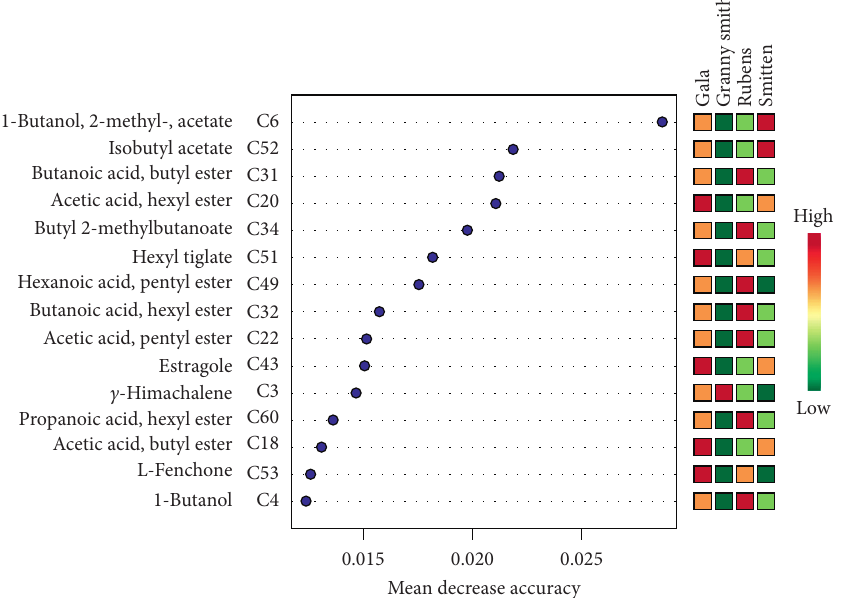
Figure 2: Representations of variety specific volatile signatures. Significant features identified by random forest within the full data set of apple cultivars. The features are ranked by the mean decrease in classification accuracy when they are permuted.